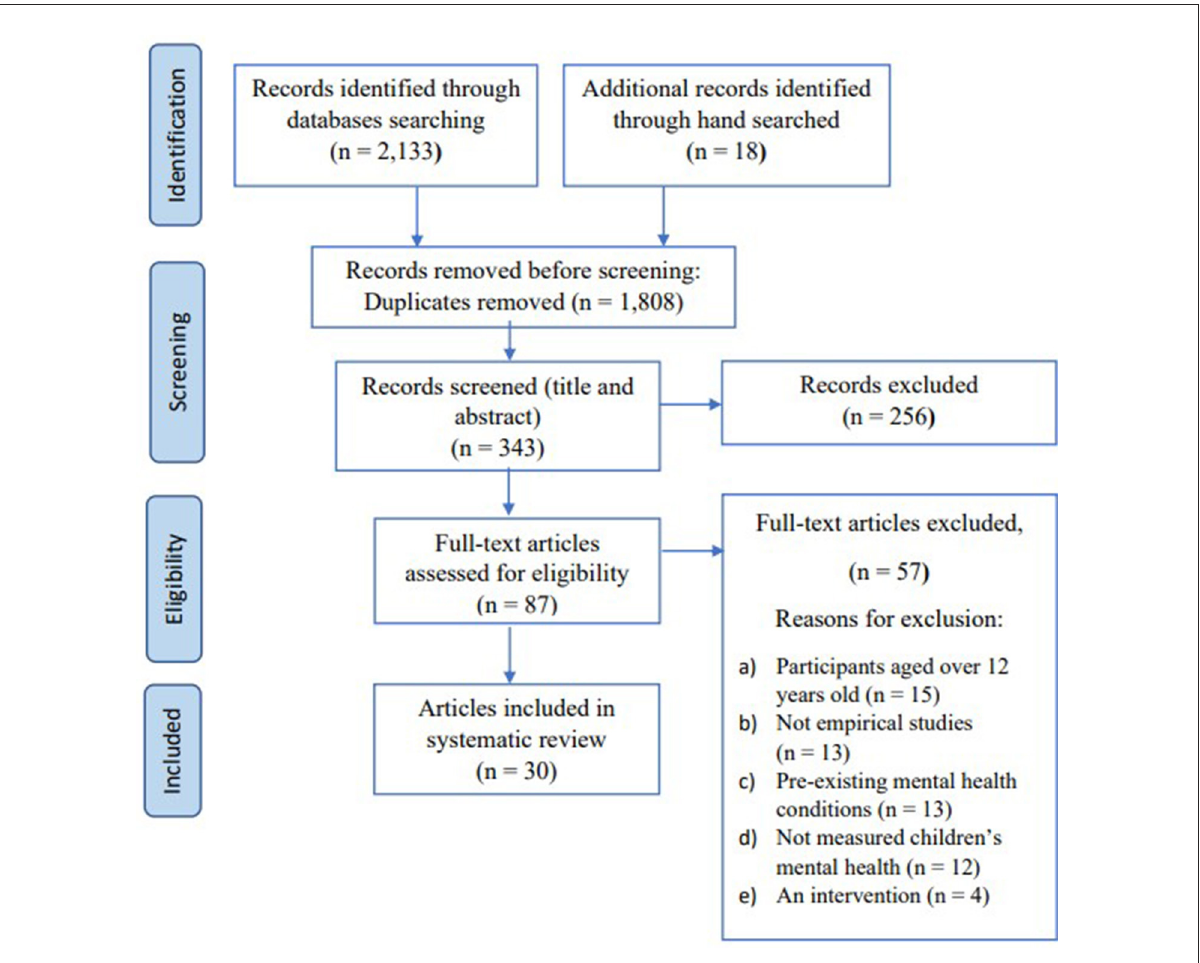
FIGURE1 PRISMA flow chart outlining the study selection